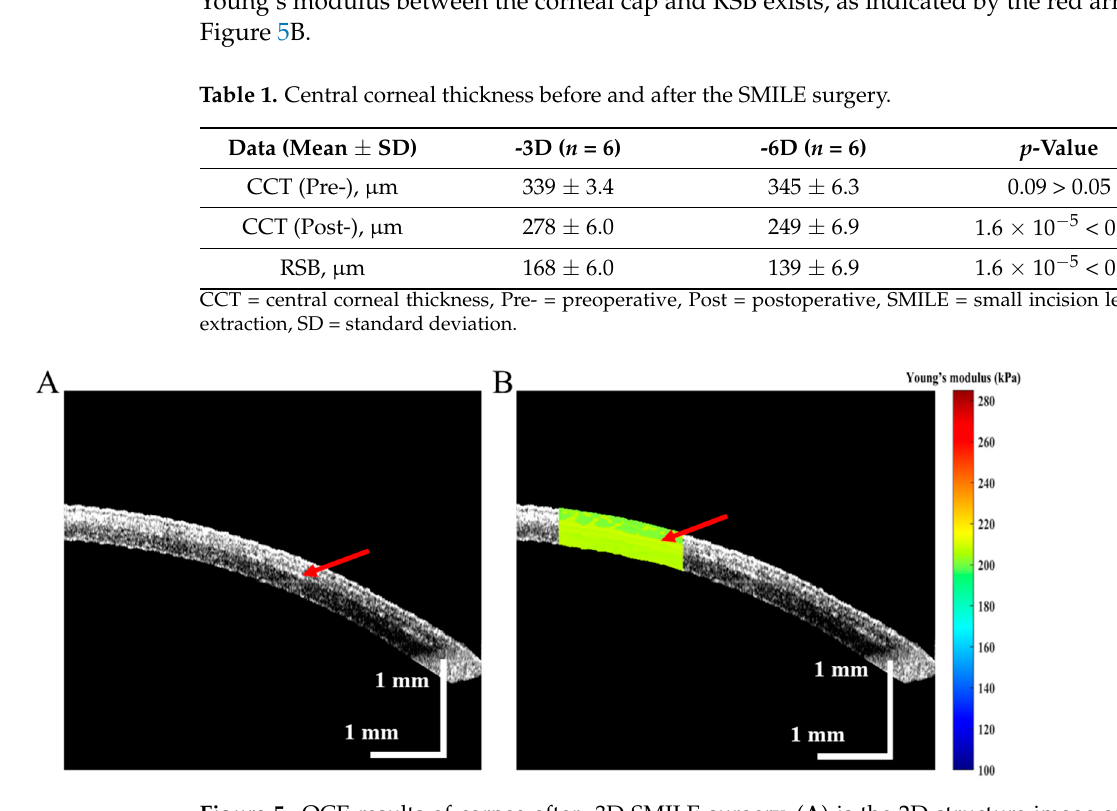
Table 1. Central corneal thickness before and after the SMILE surgery.